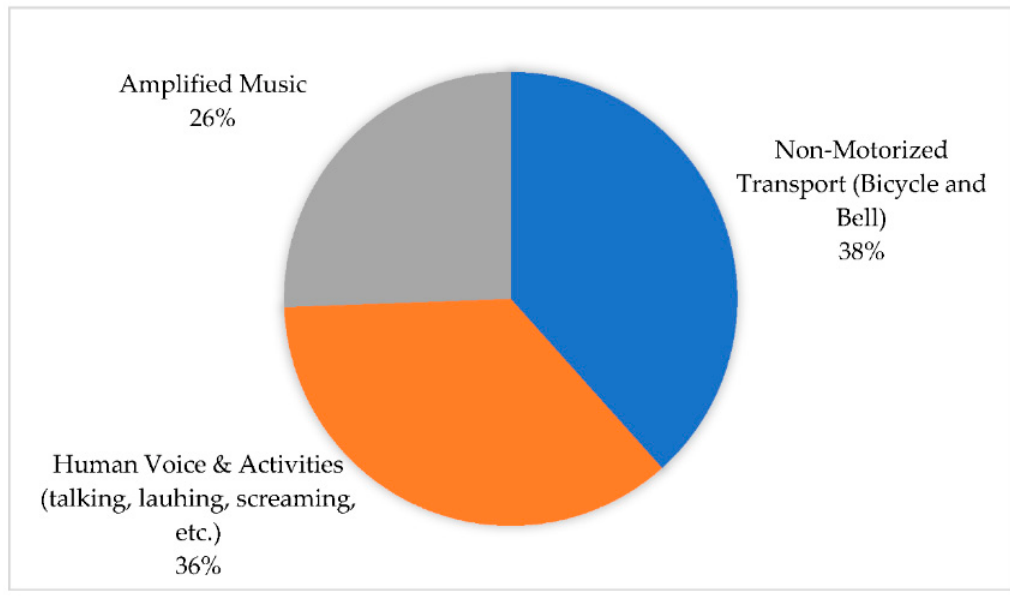
Figure 20. The classification of identified sound sources on the weekends.